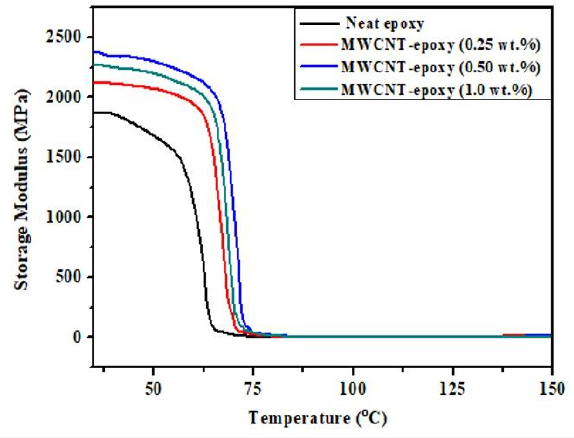
Figure 8: Storage modulus (MPa) versus temperature ( ∘ C) of neat epoxy and epoxy nanocomposites with different weight percentages of MWCNTs